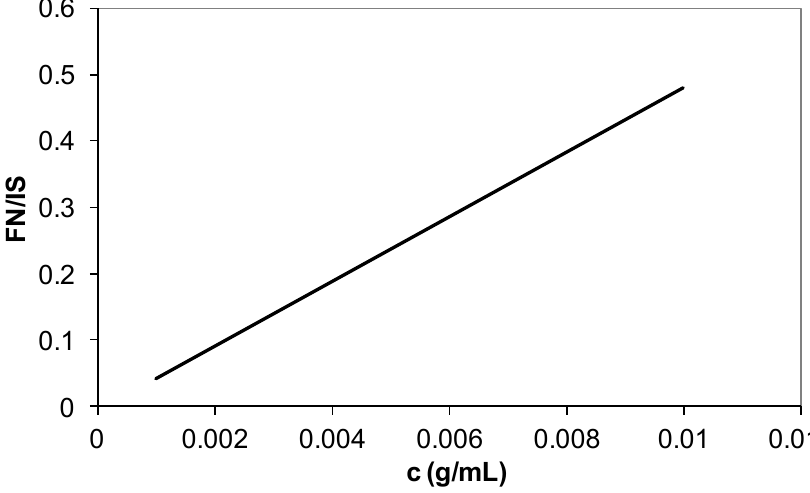
Figure 12. Calibration curve of fumaronitrile (FN) termonomer. IS: Internal